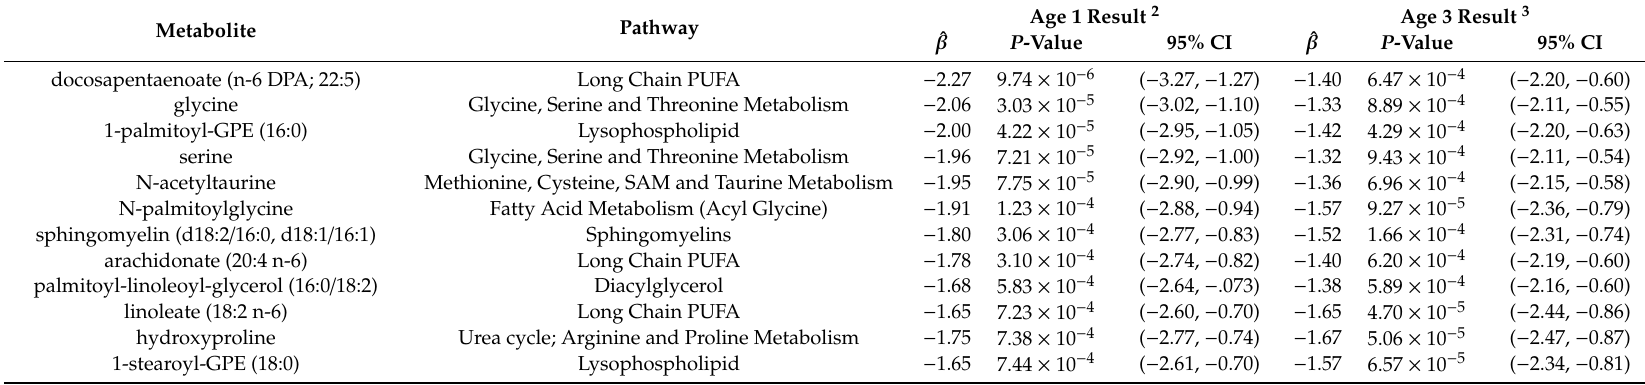
Table 3. Plasma metabolites significantly associated with 25(OH)D concentrations common to age 1 and 3 samples based on ENT80 thresholds 1.